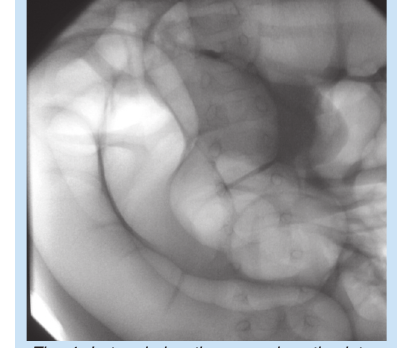
Fig. 4. Later during the procedure the intus- susceptum is driven even further. Note that this image was recorded as a spot film result- ing in a high quality image. Note the reversed position of the sigmoid once again, due to prone positioning.